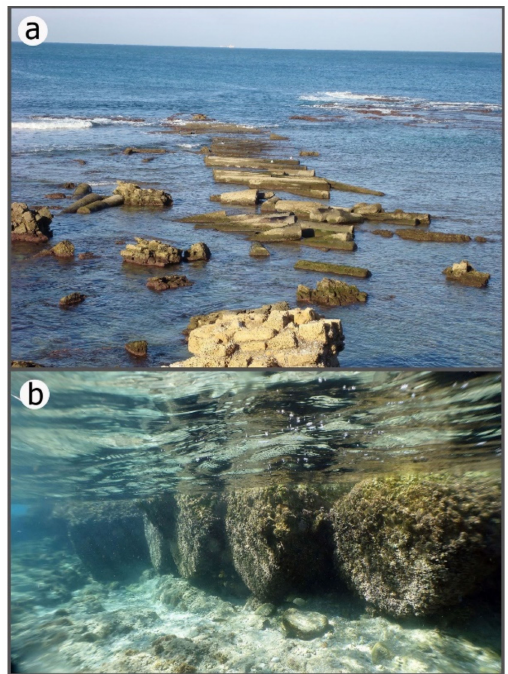
Figure 11. Crusader mole in the northern part of the central basin of the harbor: ( a ) general view of the mole, built of secondary-used Roman pillars, looking west, ( b ) underwater photo of the pillars set on the kurkar abrasion platform (for location see Figure 4 left marked with number 4).